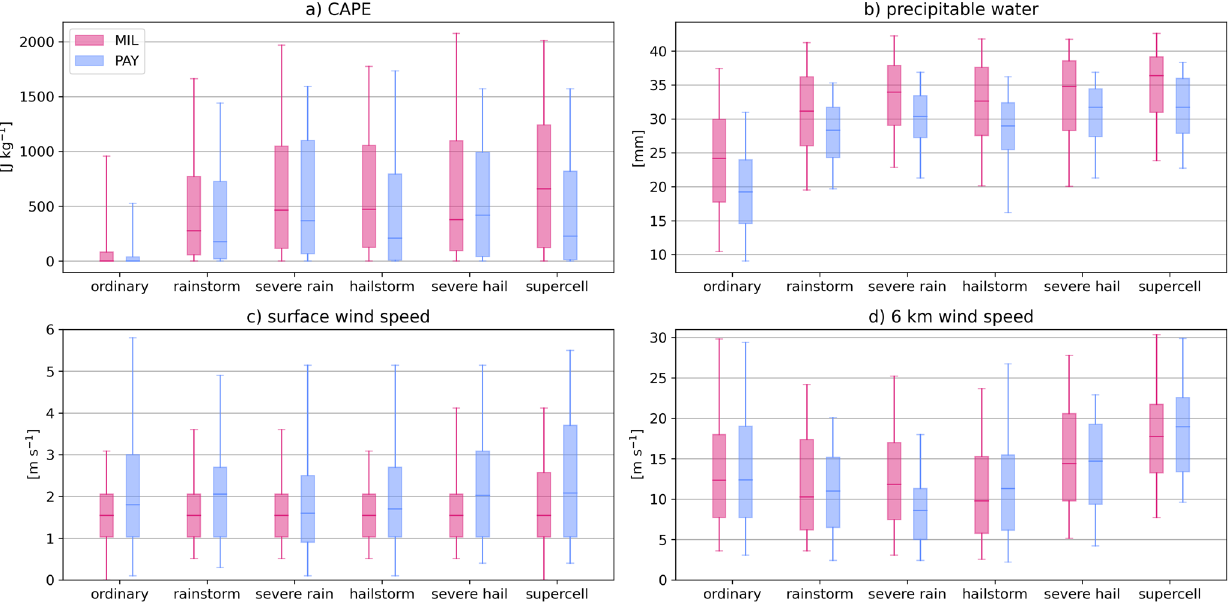
Fig. 7 Distribution of four sounding variables for the Northern and Southern Alpine regions. a CAPE, b precipitable water, c surface wind speed, d 6 km wind speed. Thunderstorms from the NW Po valley and S Prealps are assigned to the MIL sounding, while thunderstorms from the Jura, Swiss plateau and N Prealps are assigned to the PAY sounding. The boxplots depict the median (centre line), 25th and 75th percentiles (bounds of box) and 5th and 95th percentiles